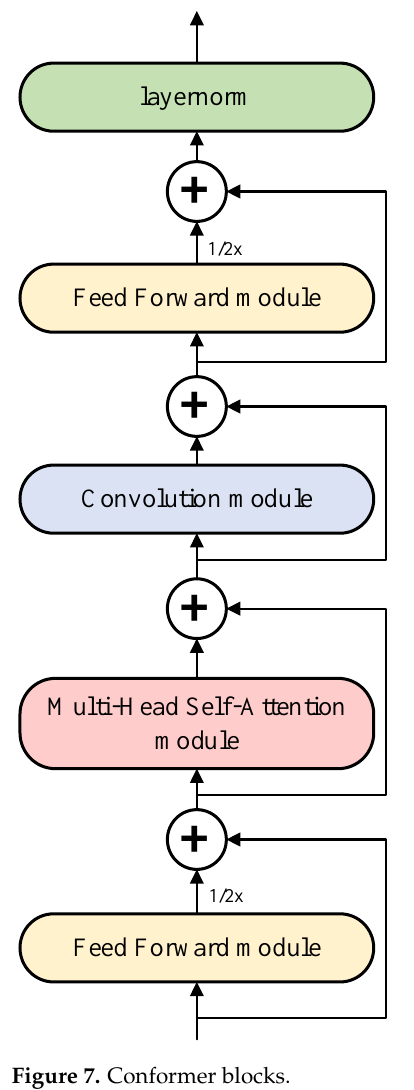
Figure 7. Conformer blocks.